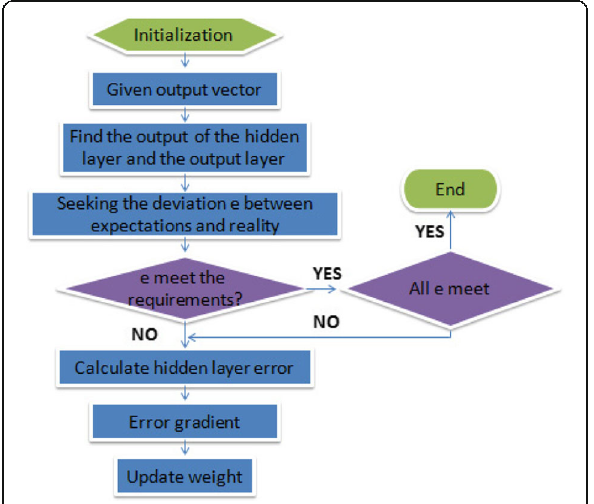
Fig. 3 The system flow based on neural